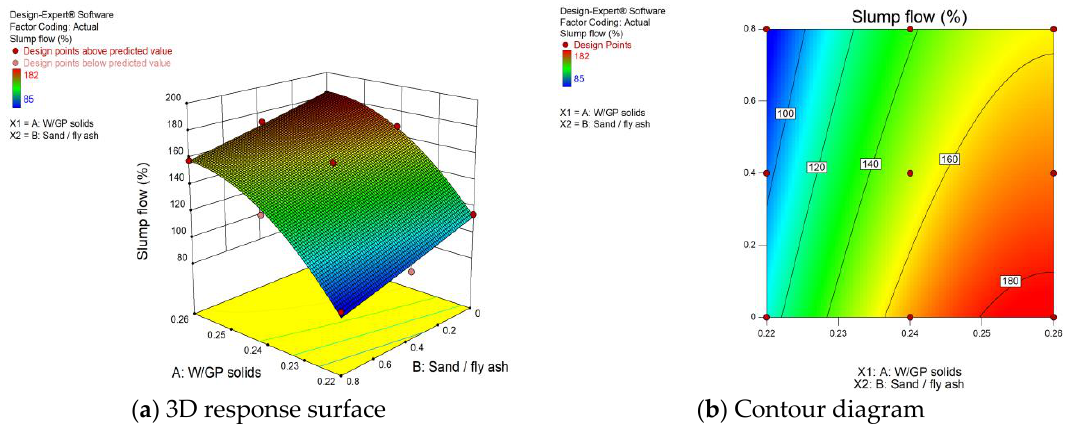
Figure 4. Slump flow versus W / GP solids and sand / fly ash. ( a ) 3D response surface, ( b ) contour diagram.